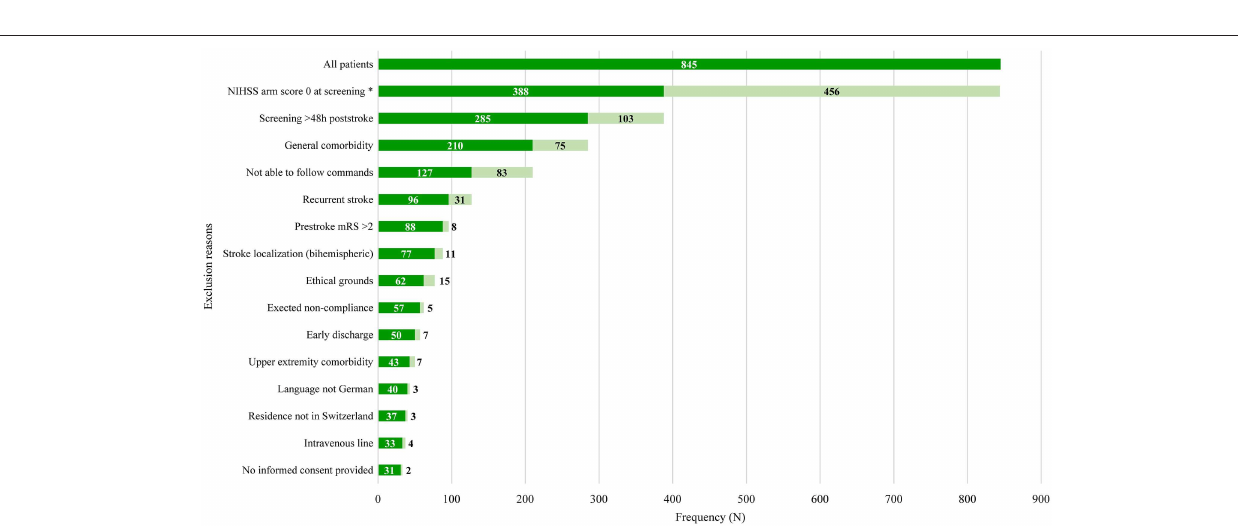
FIGURE 2 | Overview of cumulative exclusion reasons. Light-green bars indicate the number of patients fulfilling all previous criteria but not the current criterion. Dark-green bars indicate number of patients fulfilling all previous criteria including the current criterion. Exclusion reasons arranged in ascending order based on their prevalence. Stroke localization (bihemispheric) and recurrent stroke refer to the inclusion criterion “first-ever unilateral ischemic stroke.” The criterion “comorbidity” was divided into general comorbidity (e.g., Morbus Parkinson) and specific upper limb comorbidity (e.g., arthrosis of the hand, humerus fracture). Patients not residing in Switzerland could not be enrolled, as they would not be able to return for the follow-up visits. h, hours; NIHSS, National Institutes of Health Stroke Scale; mRS, modified Rankin Scale; *One data point